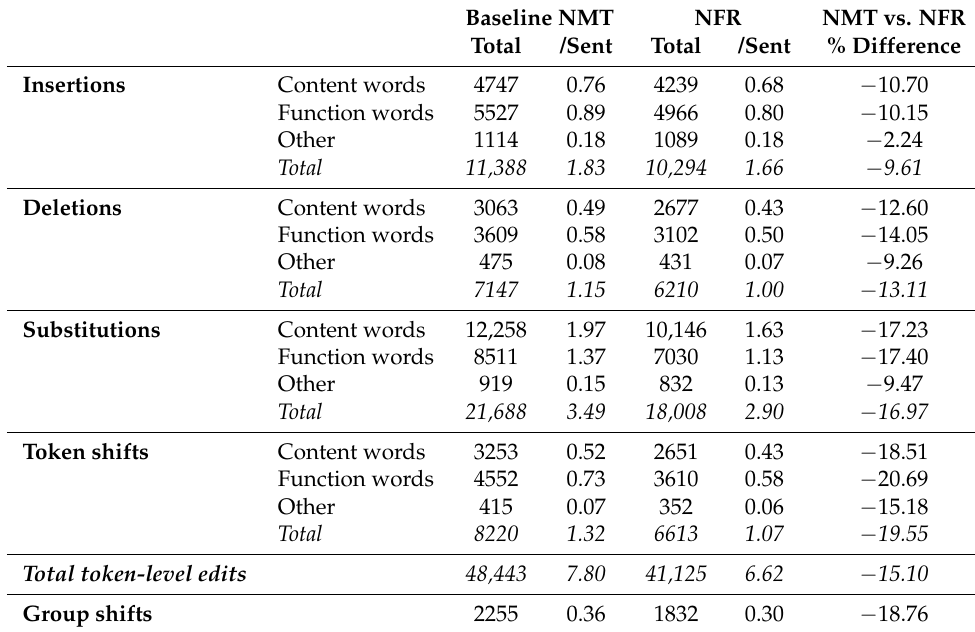
Table 9. Number of TER edits per edit type (in total and per sentence), for content words, function words and other tokens/words and percentage difference between baseline NMT and NFR